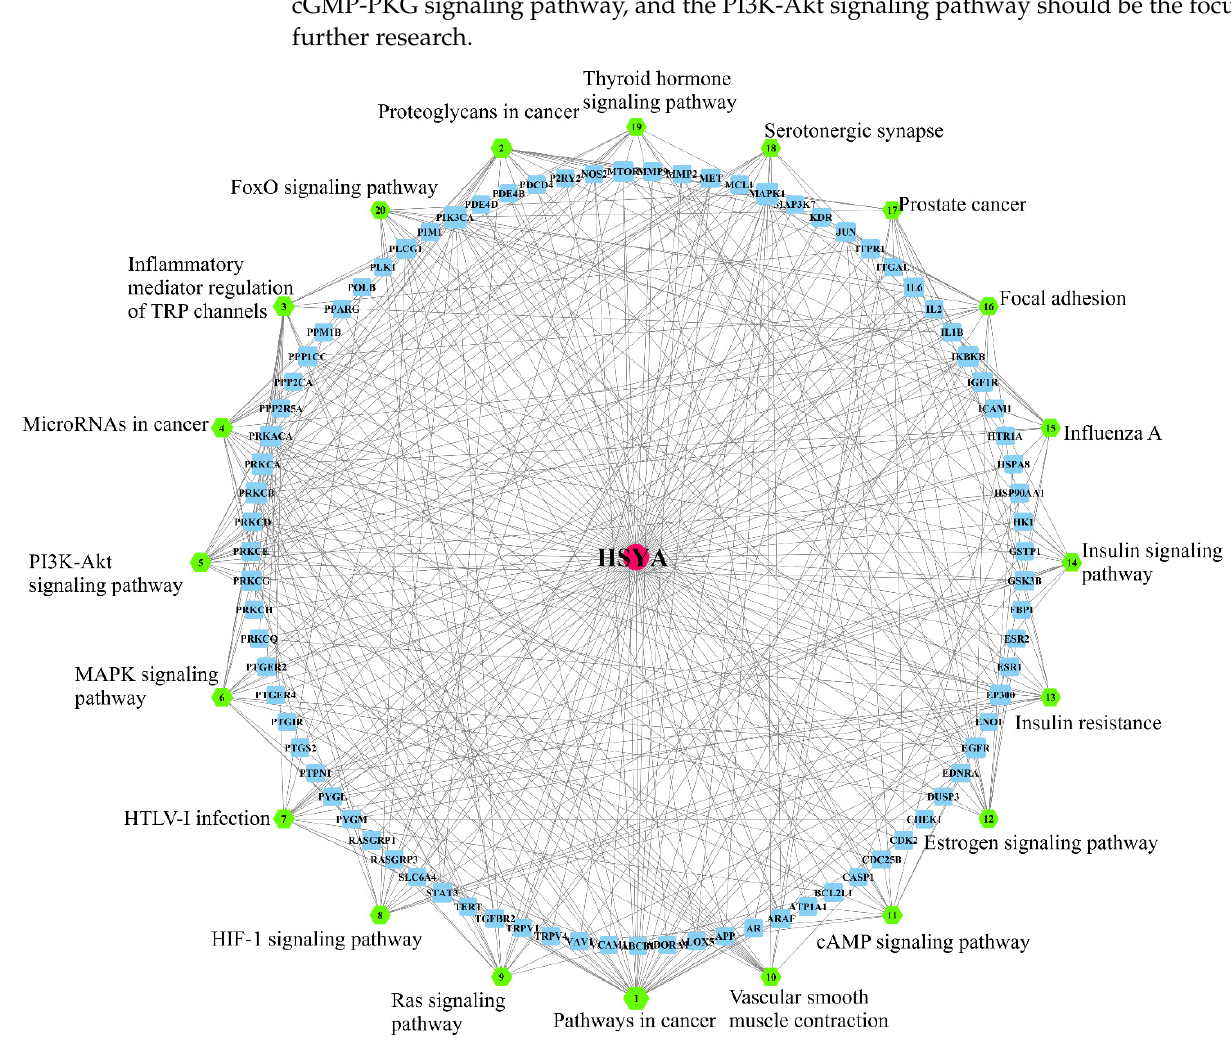
Figure 3. The target pathway network: red dots indicate the active ingredients; blue dots indicate the gene names; green dots indicate the signal pathways.